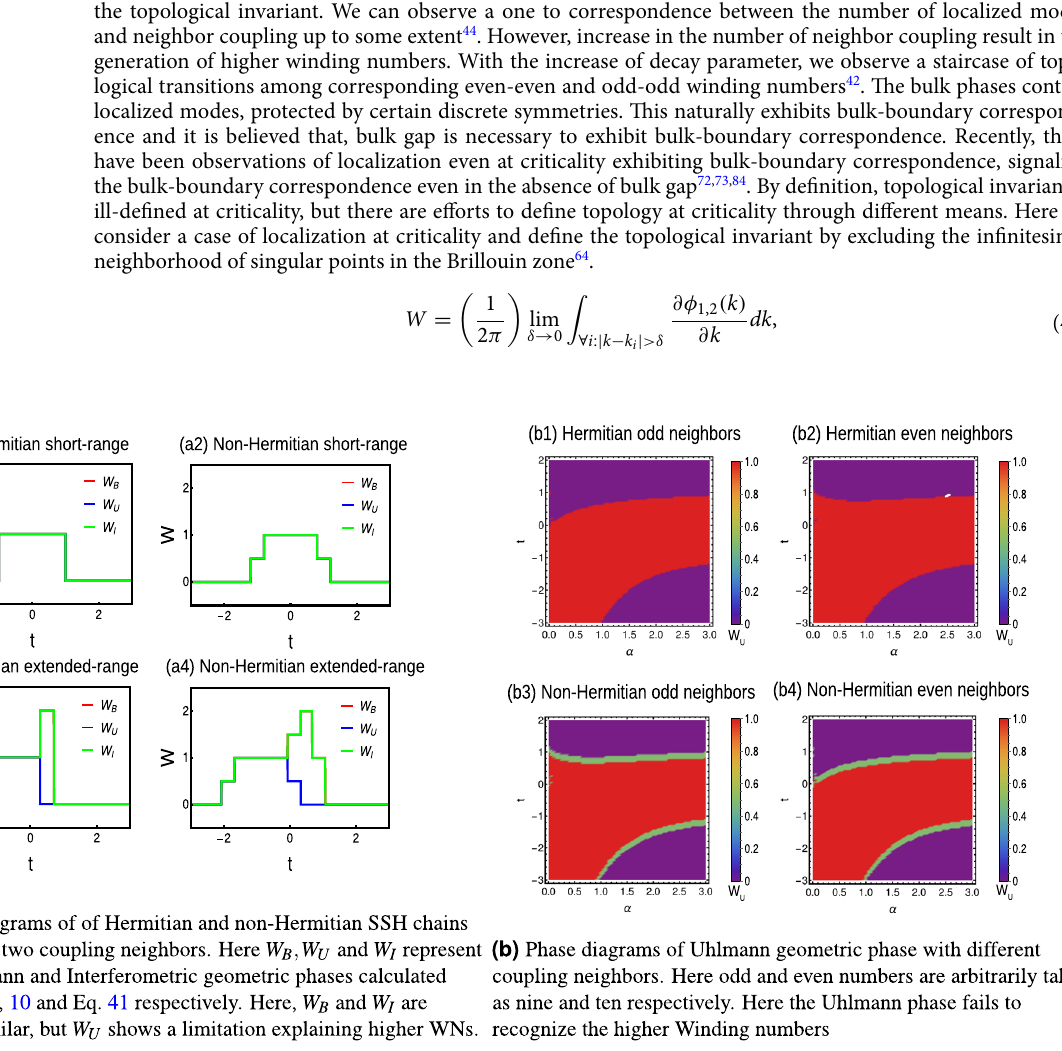
Figure 10. (Color online) ( a ) Comparison of different geometric phases. ( b ) Behavior of Uhlmann phase for higher coupling